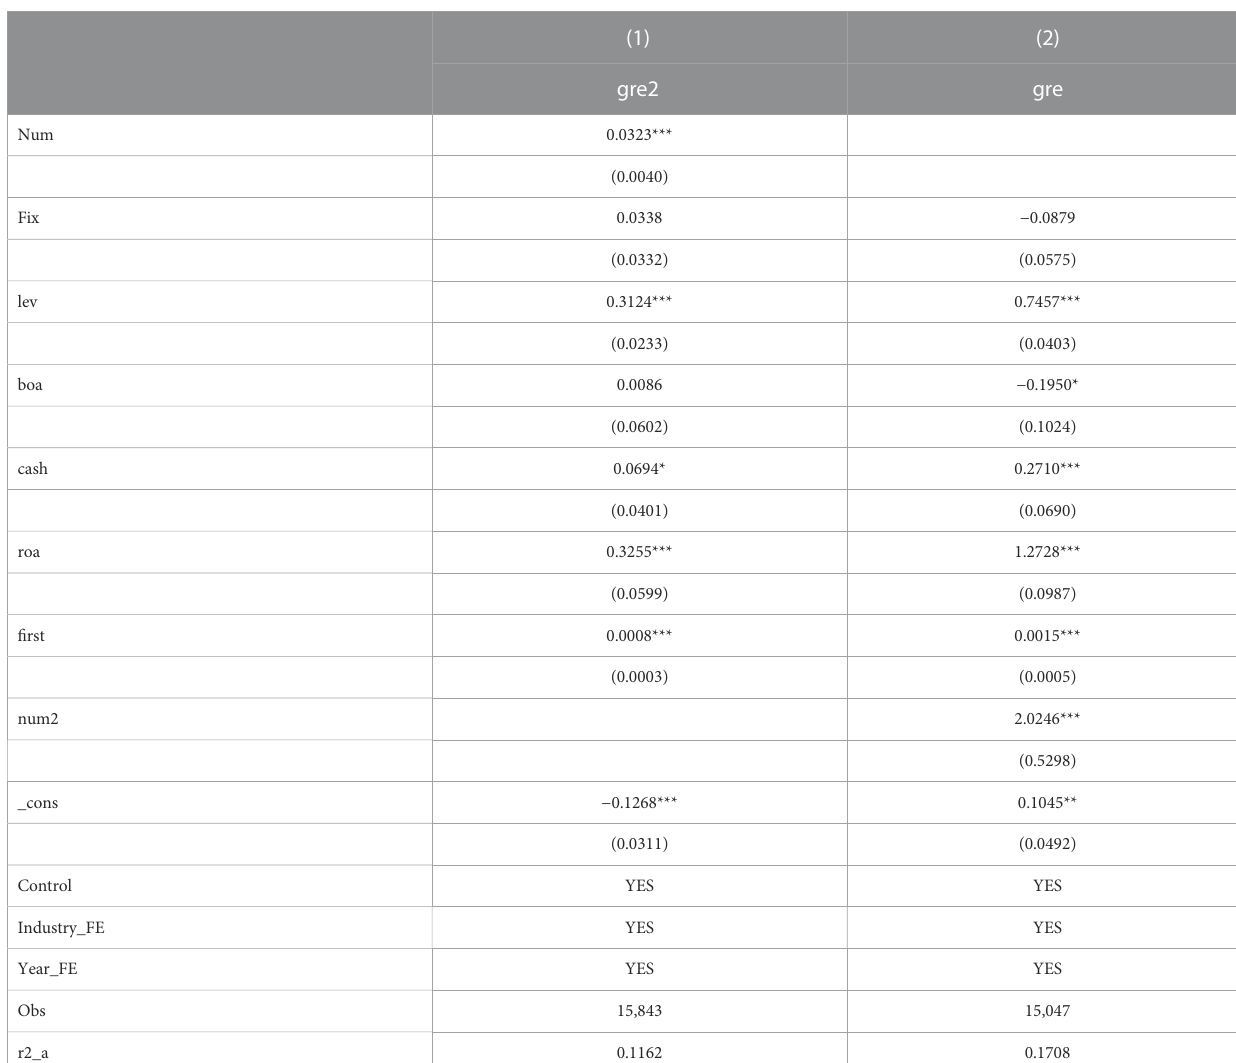
TABLE 4 Robustness test